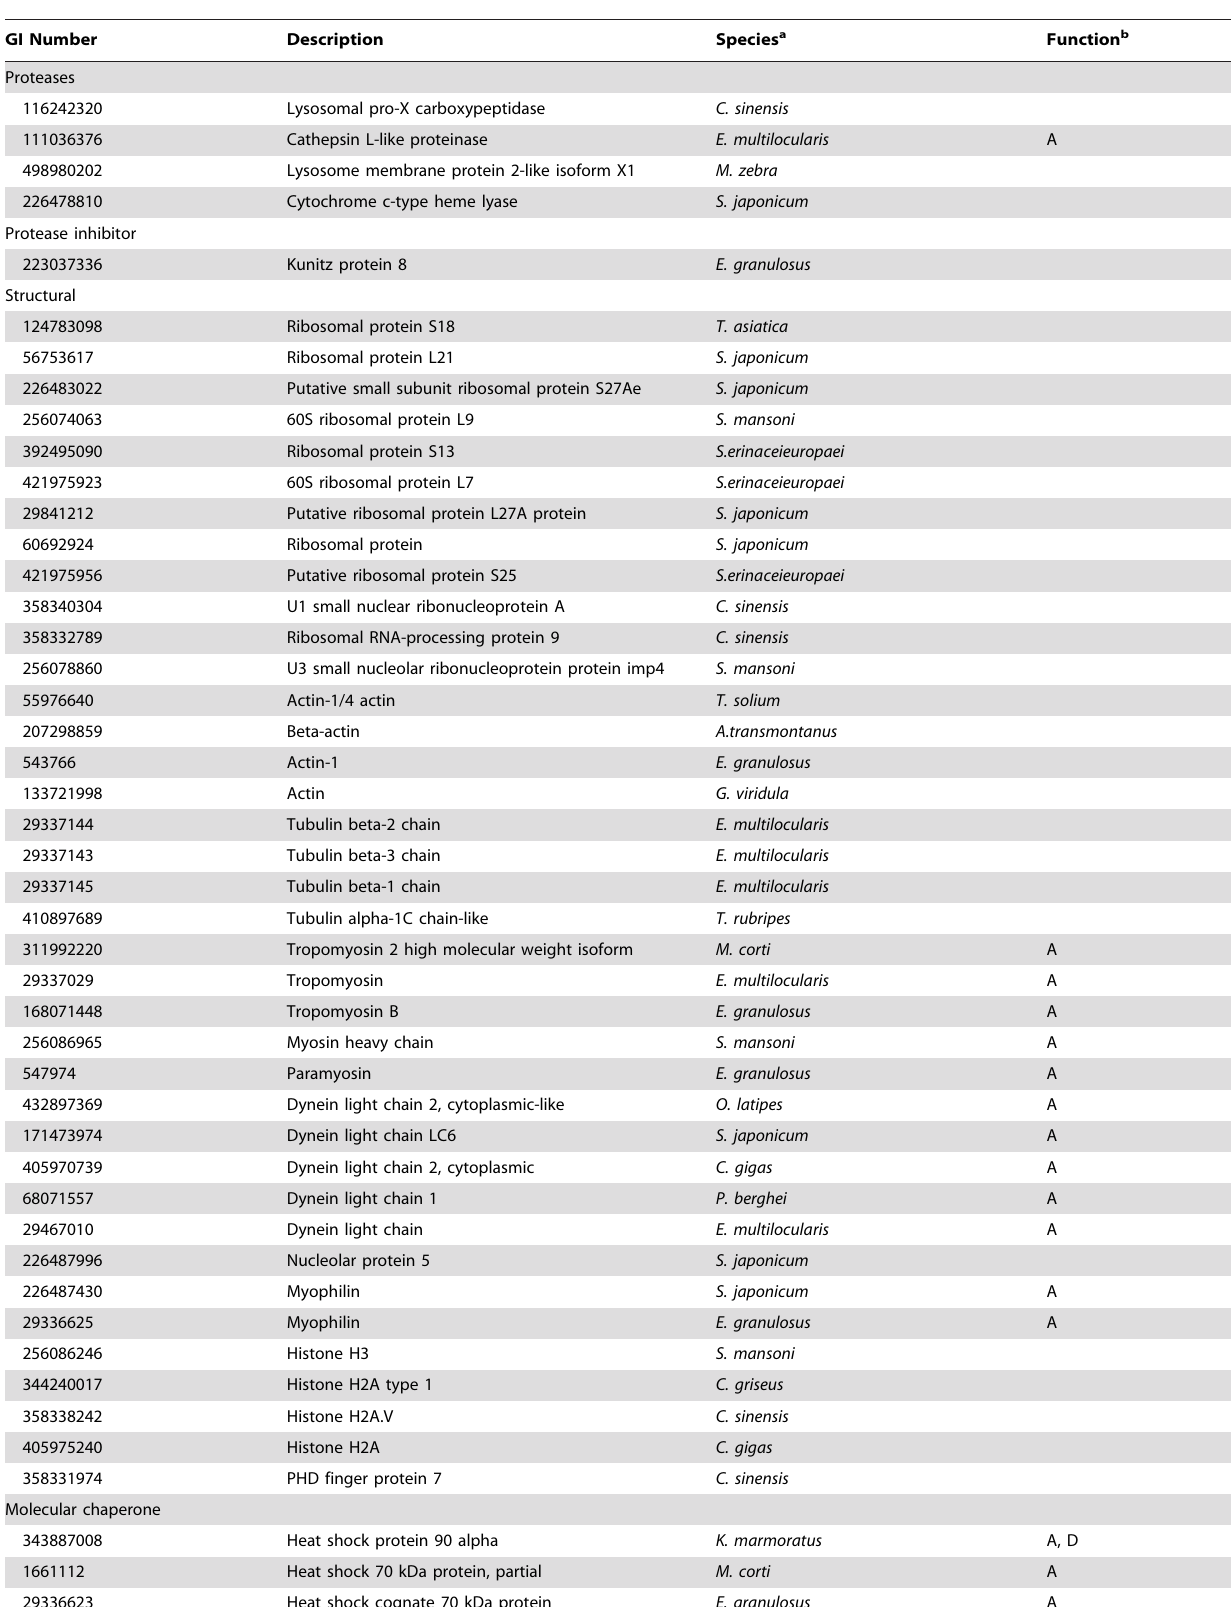
Table 4. The potential functional proteins with a high abundance in the ESPs from EgPSCs transcriptome.